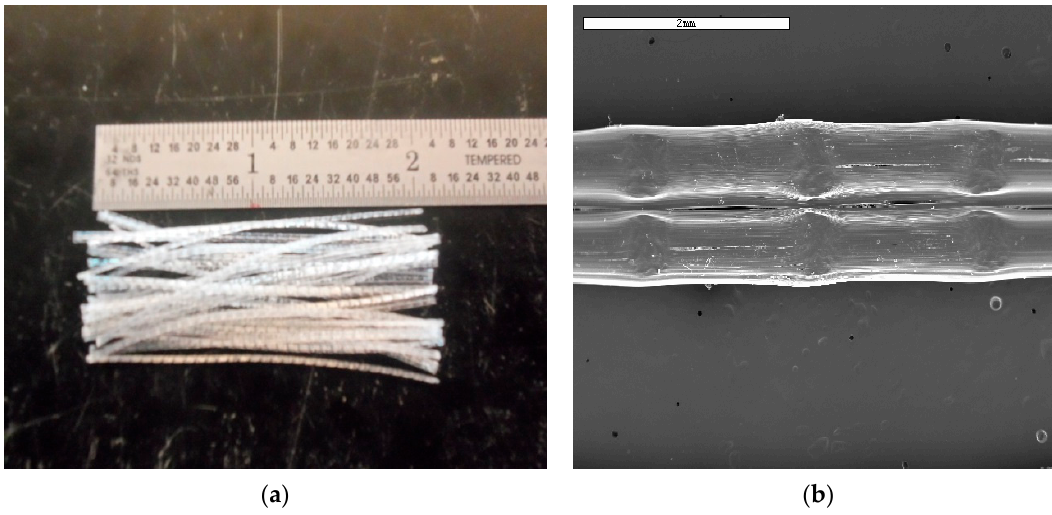
Figure 1. PP fibers: ( a ) photograph of fibers, ( b ) SEM image of fiber showing cross-linked filaments.